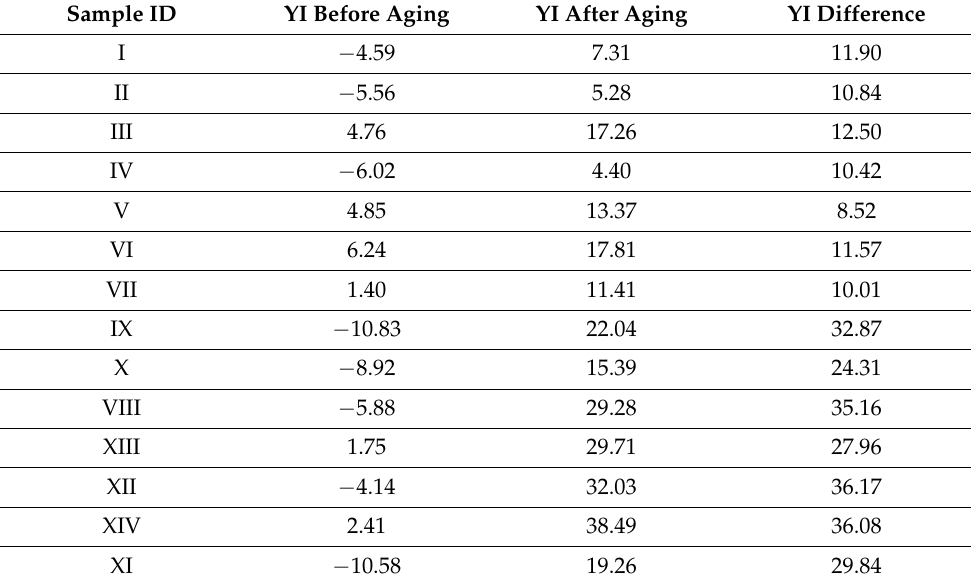
Figure 2. Photodegradation of polycarbonate. The first group of samples containing MDI/PMDI in their composition and without the addition of hydrated magnesium silicate is characterized by the lowest YI value. Among this group of samples, no relation between the amount of MDI/PMDI addition and the YI value was found (Table 2). Table 2. Yellowing index of analyzed composites .